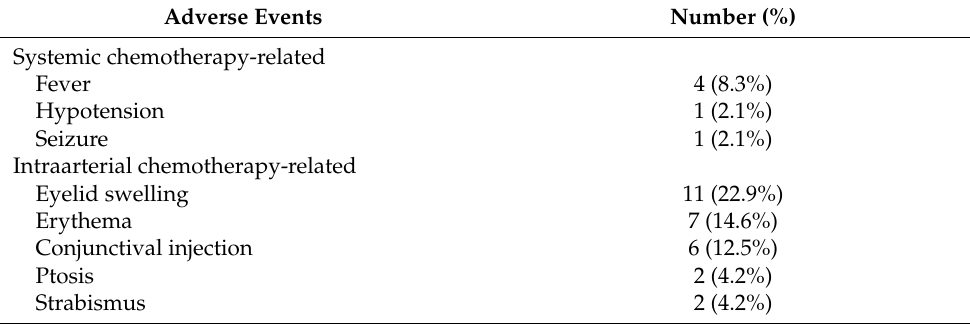
Table 3. Adverse events related to treatments in retinoblastoma patients who received intravenous chemotherapy and intraarterial